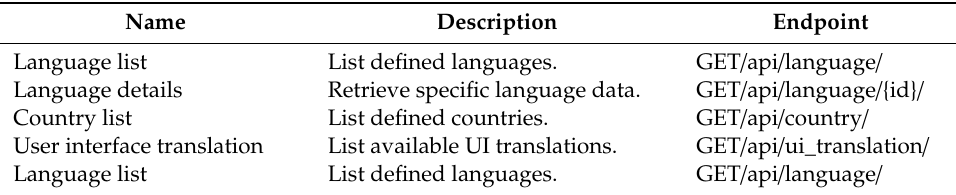
Table 7. Internationalization endpoints.